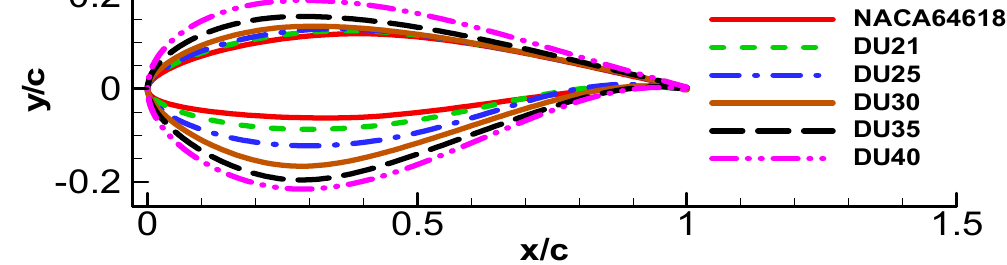
Figure 15. Geometric shape of airfoils adopted by the NREL 5 MW blade.